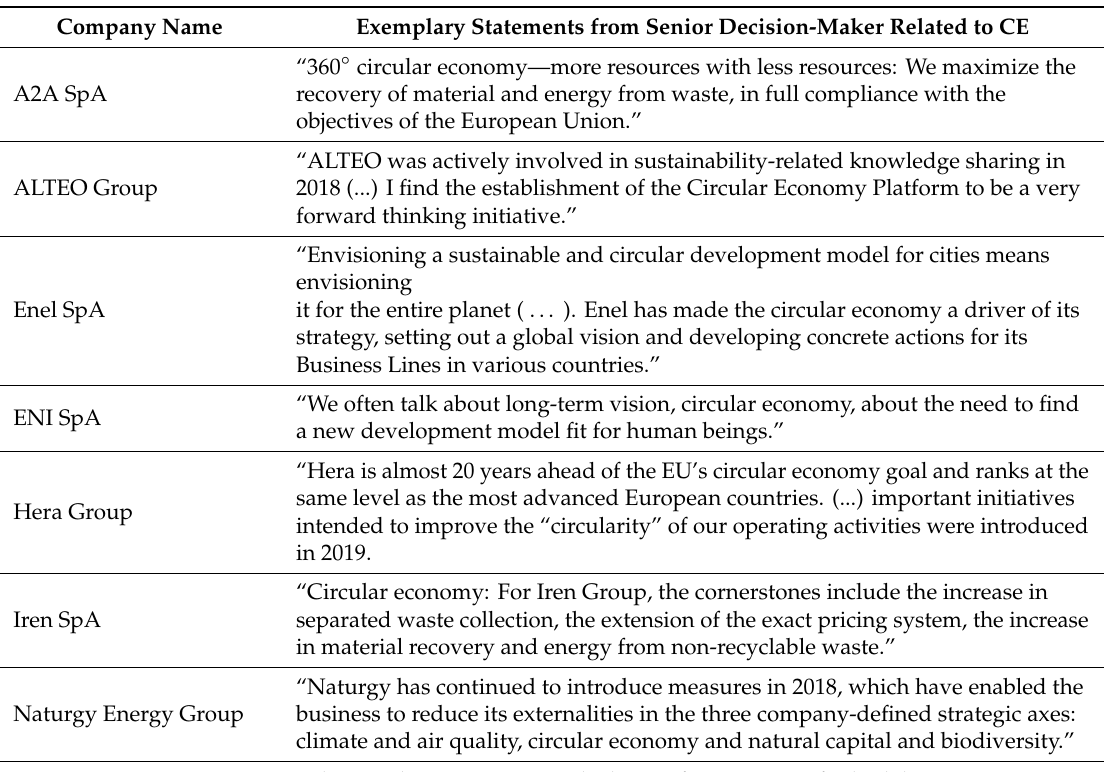
Table 2. Examples of statements from senior decision-maker in relation to circular economy (CE)